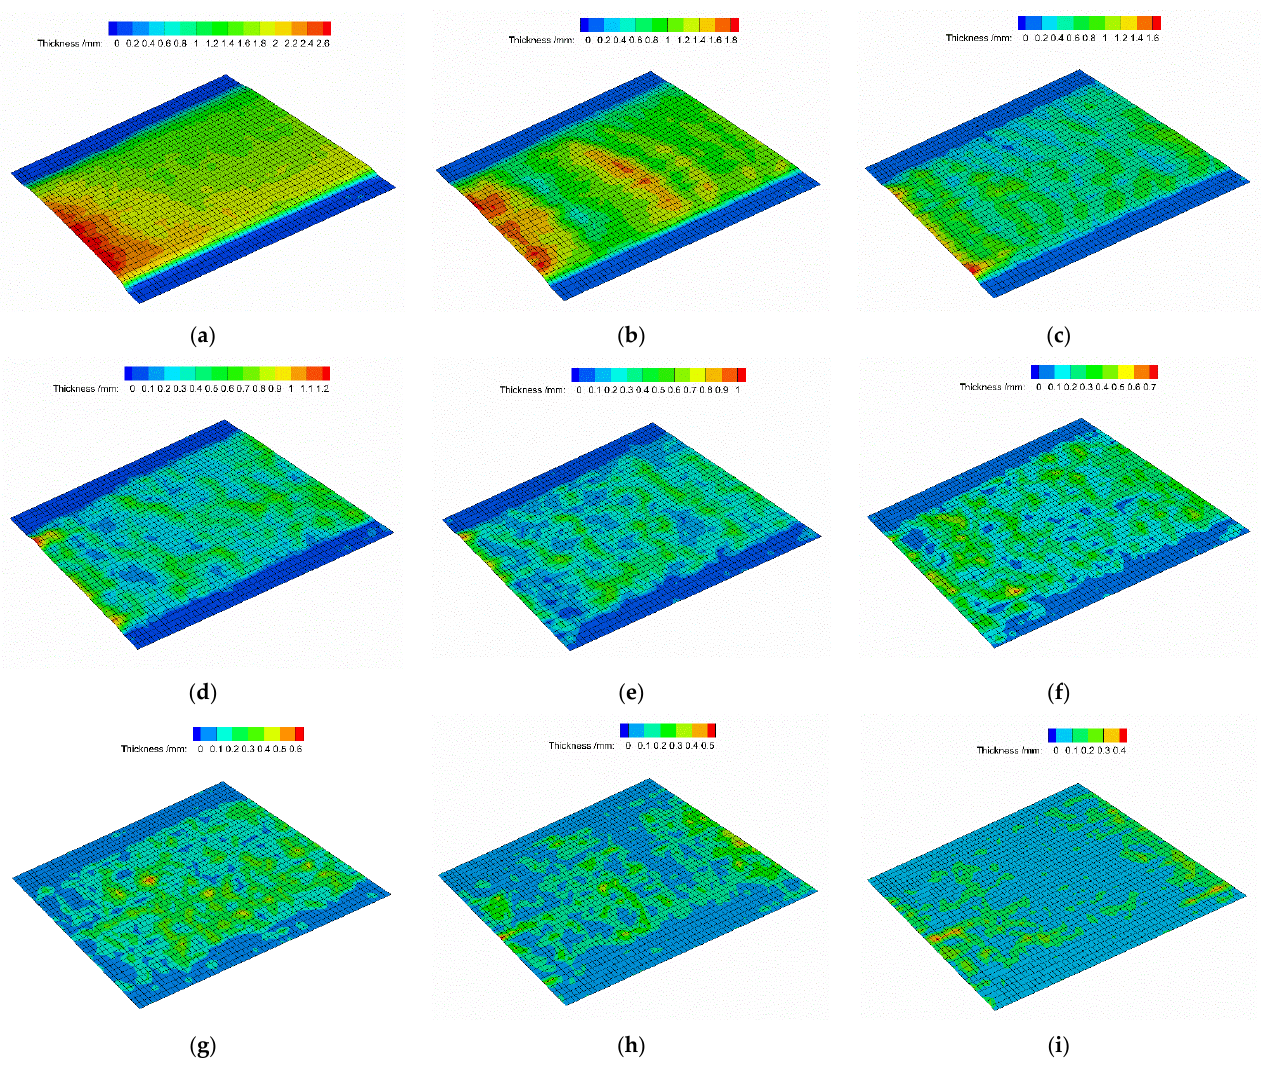
Figure 5. The images of the water film flow experiments at ( a ) V = 10 m/s; ( b ) V = 15 m/s; ( c ) V = 20 m/s; ( d ) V = 25 m/s; ( e ) V = 30 m/s; ( f ) V = 35 m/s; ( g ) V = 40 m/s; ( h ) V = 45 m/s; ( i ) V = 50 m/s.